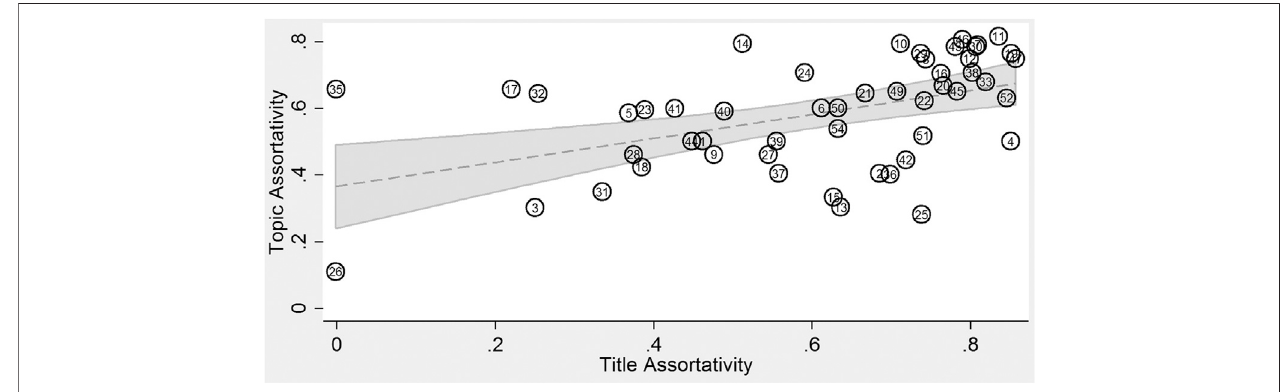
FIGURE3| Relationshipbetween cross-referenceassortativityat thetitle and topiclevel.Titles arematchedwiththetopic thatismostcloselyassociatedwith that title as reported in Supplementary Table S7 . Cross-references often track subject matter (as proxied by title and